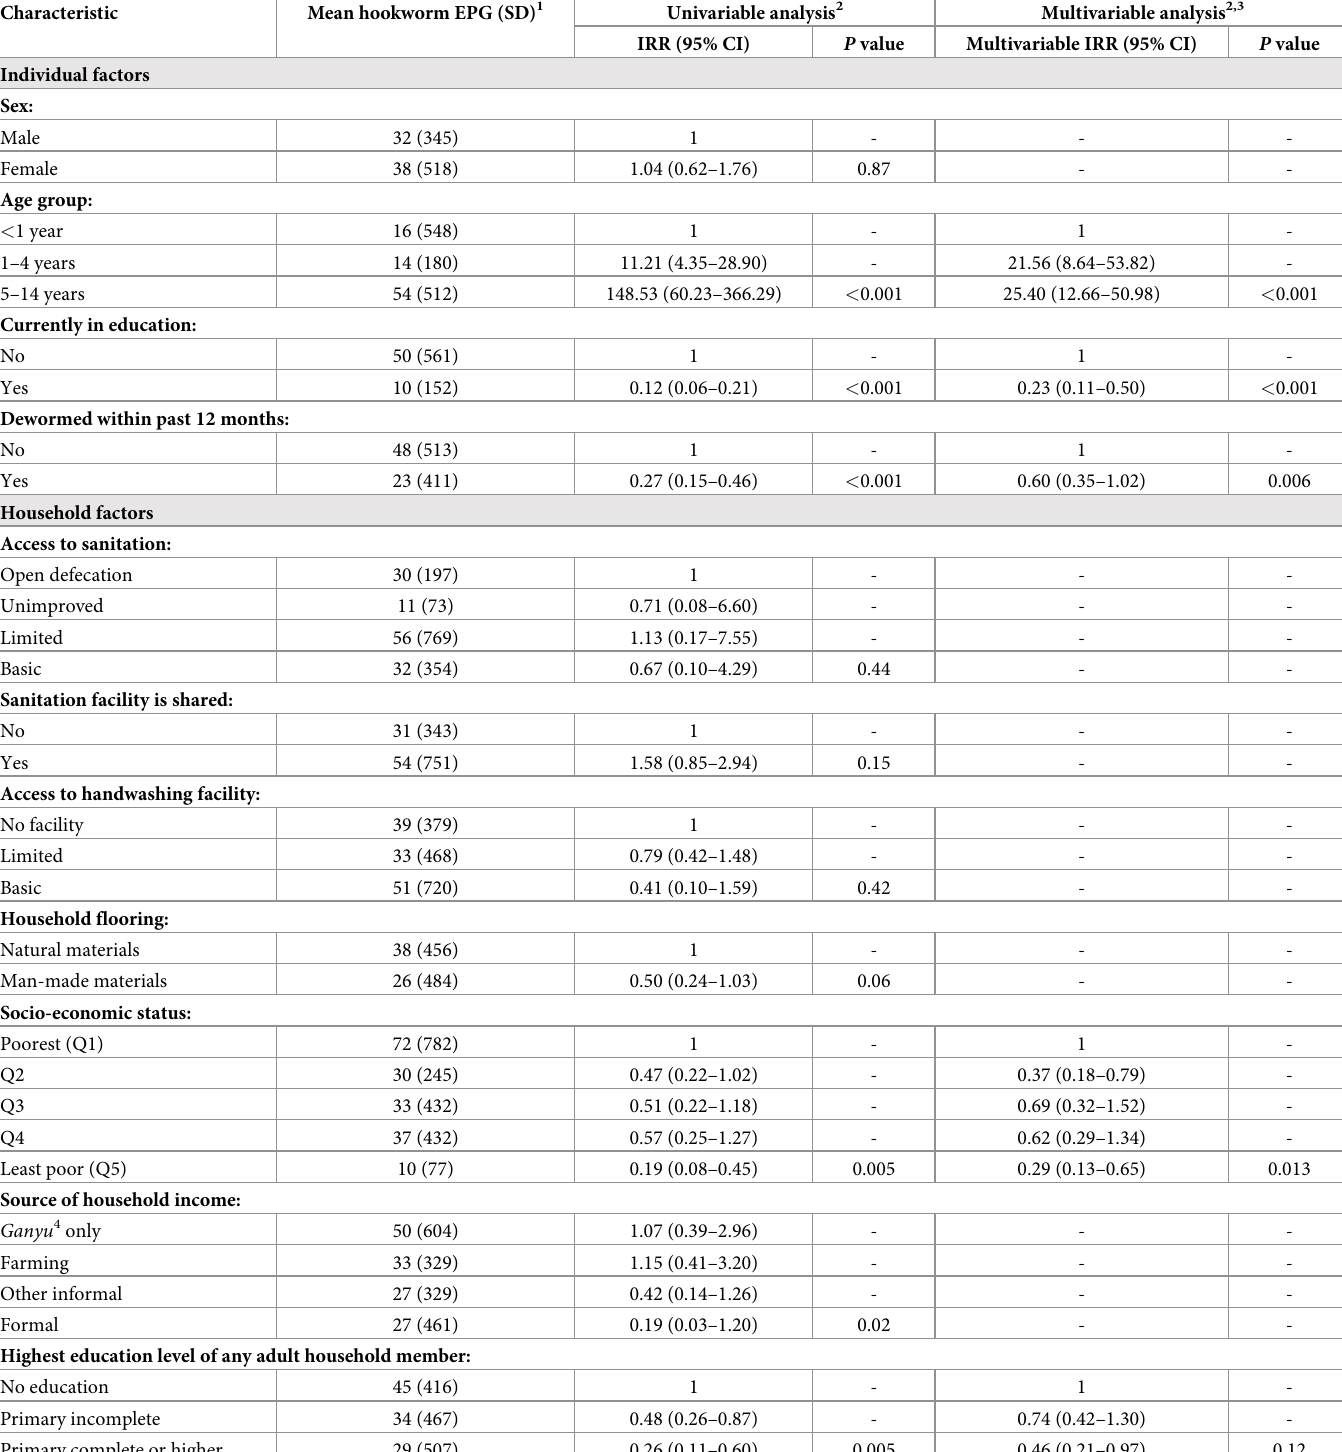
Table 3. Predictors of intensity of hookworm infection amongst preschool-age children, school-age children, and adults in Namwera, Mangochi district, Malawi in 2018.